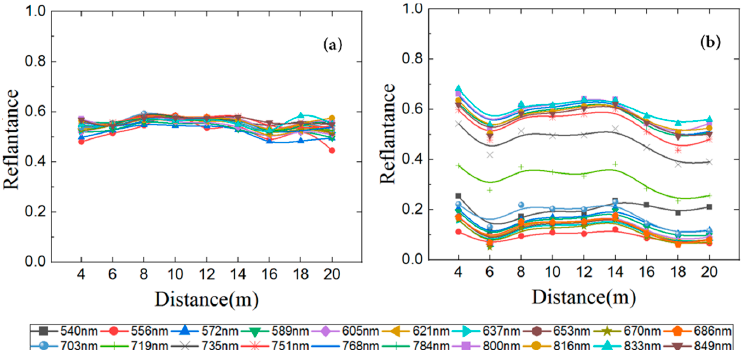
Figure 10. Relative correction results of all wavelengths for ( a ) the 50% standard reflectance panel and ( b ) leaf target versus distance, the 99% standard reflectance panel is used as a reference.